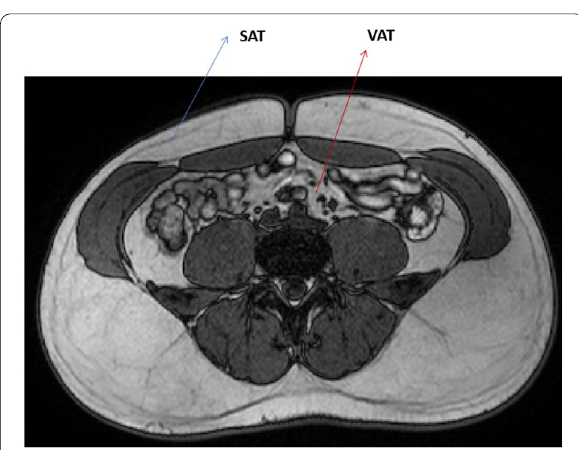
Fig. 3 Distribution of subcutaneous (SAT) and visceral (VAT) adipose tissue in magnetic resonance